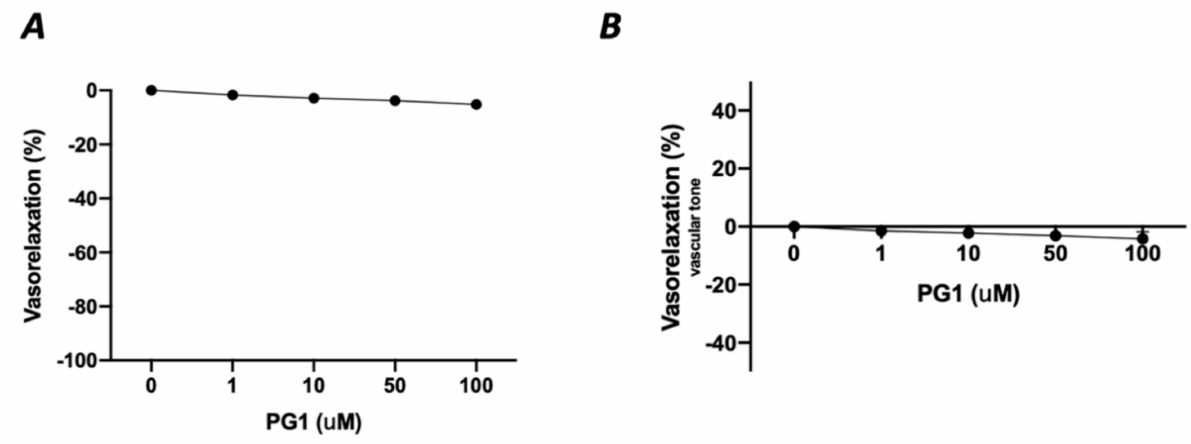
Figure 1. ( A ) Assessment of possible vascular effect of PG1 at increasing doses 1, 10, 50 and 100 µ M on mice mesenteric arteries preconstricted with phenylephrine (10 − 9 to 10 − 5 M). ( B ) Evaluation of possible direct vascular action of increasing doses of PG1 (1, 10, 50 and 100 µ M) on uncontracted equilibrated mice mesenteric